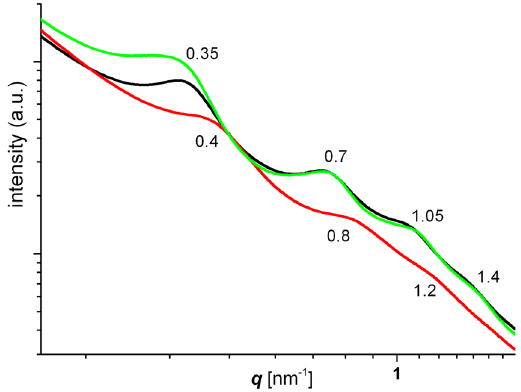
scattering (Fig. 3, whole q-range: Fig. S5) shows sets of harmonic humps of lamellar arrays with repeat distances of 15.7 for b-PES and 18 nm for b-HBA and PES-NB. Intriguingly, in case of b-PES, higher TEM magnification reveals a substructure of typically three layers separated by 2 nm (Fig. 2d, arrows). These stay undetected in